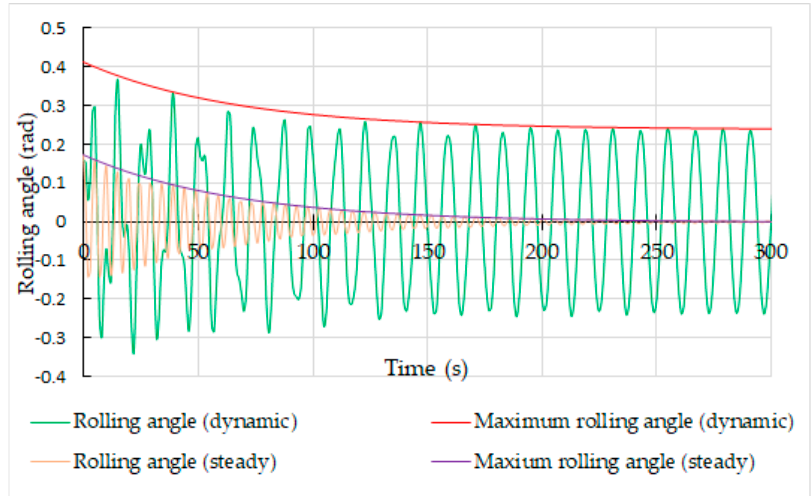
Figure 6. Representation of the maximum rolling angles in static (due to a single and external force) and in dynamic conditions (under the influence of successive waves) and their corresponding exponential limit curves.